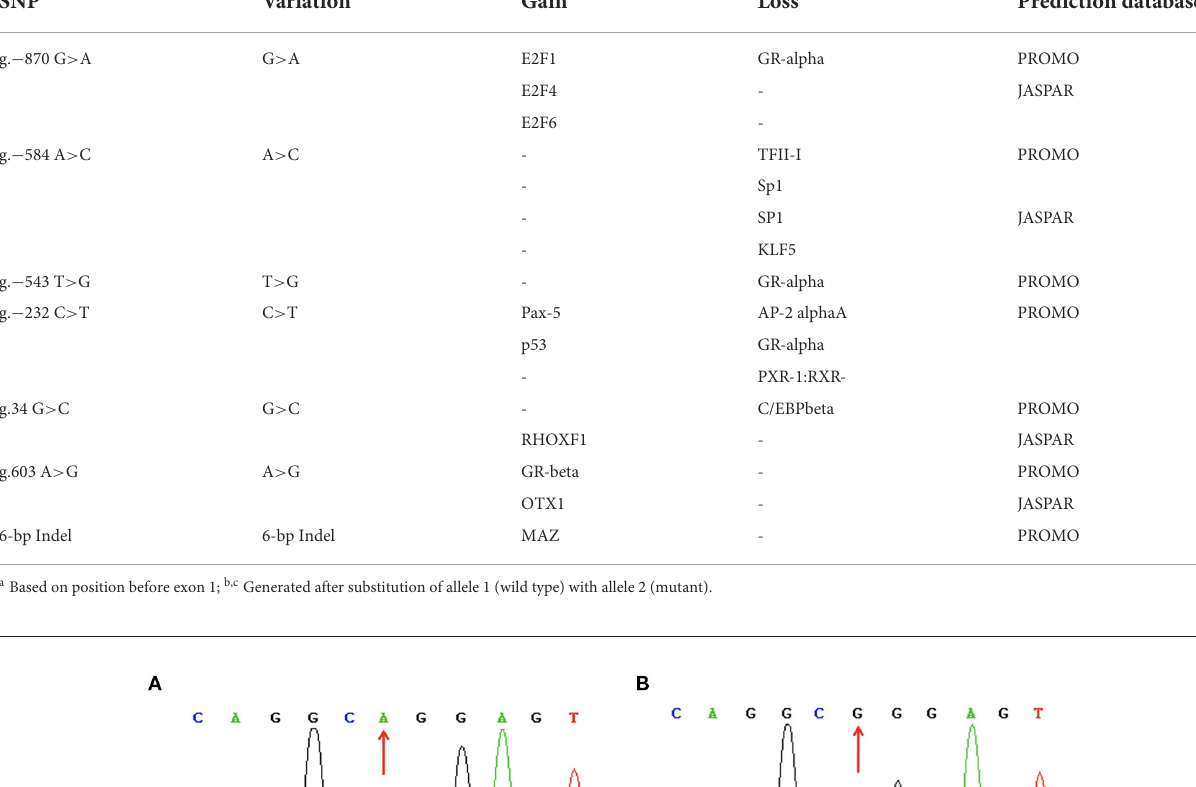
TABLE 1 Putative transcriptional factor binding sites in the 5’ non-coding region of porcine STAT3 gene. SNP a Variation Gain b Loss c Prediction database